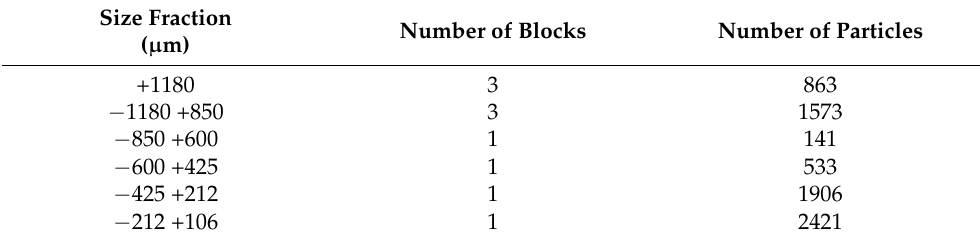
Table 2. The number of blocks examined and particles analyzed using automated QEMSCAN mineralogical